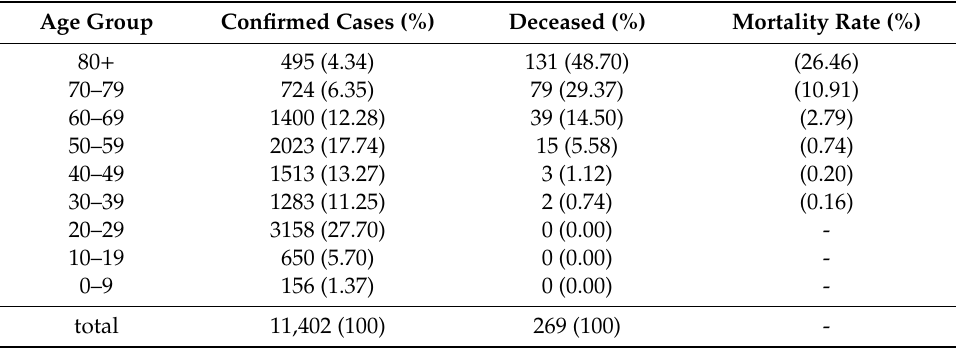
Figure 3. Trend of new confirmed cases. Table 1. Total cases by age as of 29 May